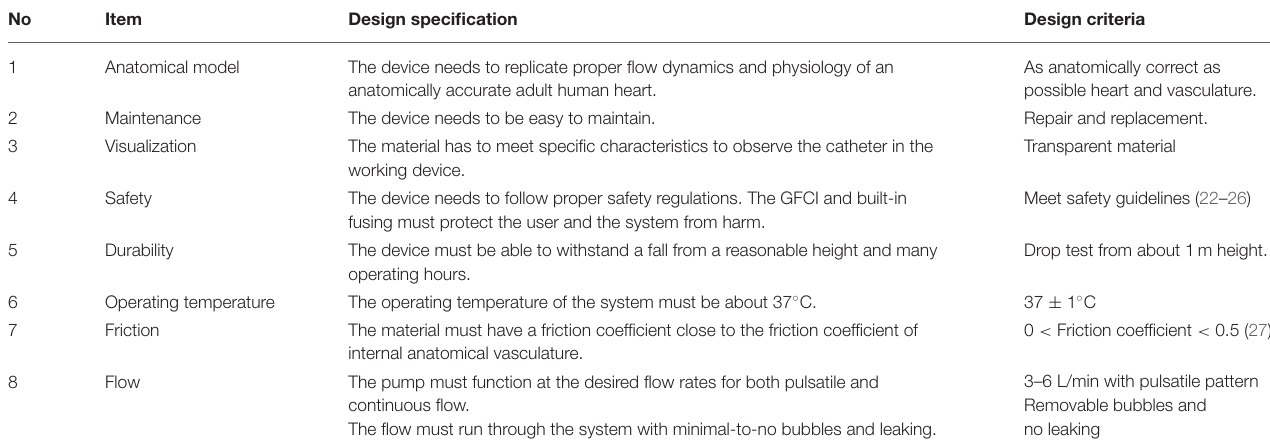
TABLE 1 | Design specification and criteria for the cardiovascular flow simulator.